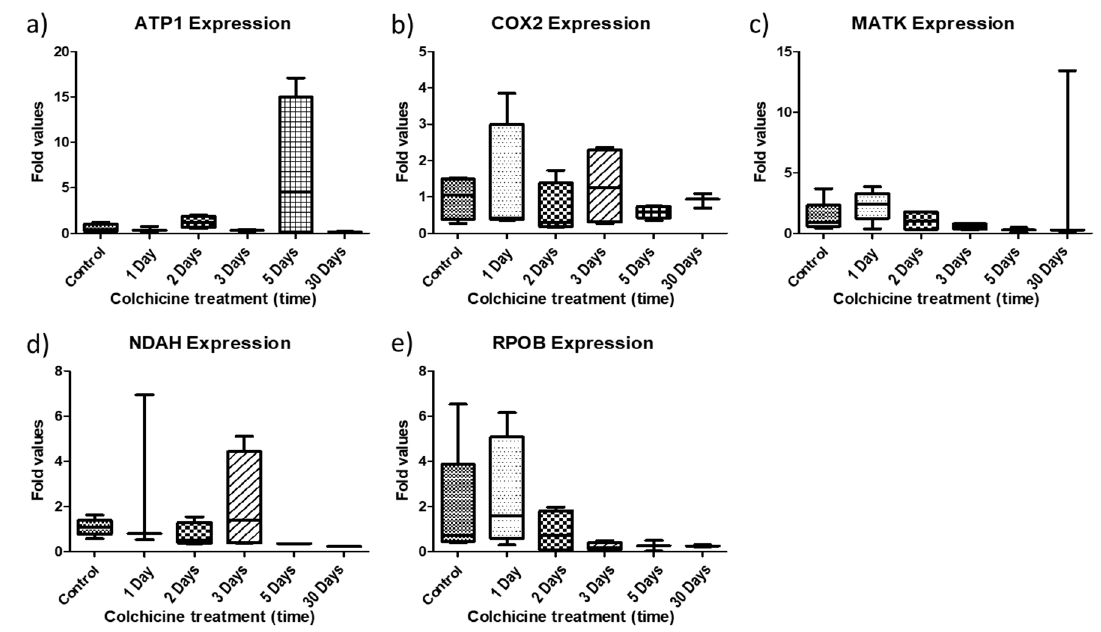
Figure 6. Graphs of relative expression of ATP1, COX2, MATK, NADH and RPOB genes in blueberry plants subjected to different treatments with colchicine (1 day, 2 days, 3 days, 5 days and 30 days). The GAPDH gene was used as the reference gene. ( a ) ATP1 ; ( b ) COX2 ; ( c ) MATK , ( d ) NADH ; ( e ) RPOB .